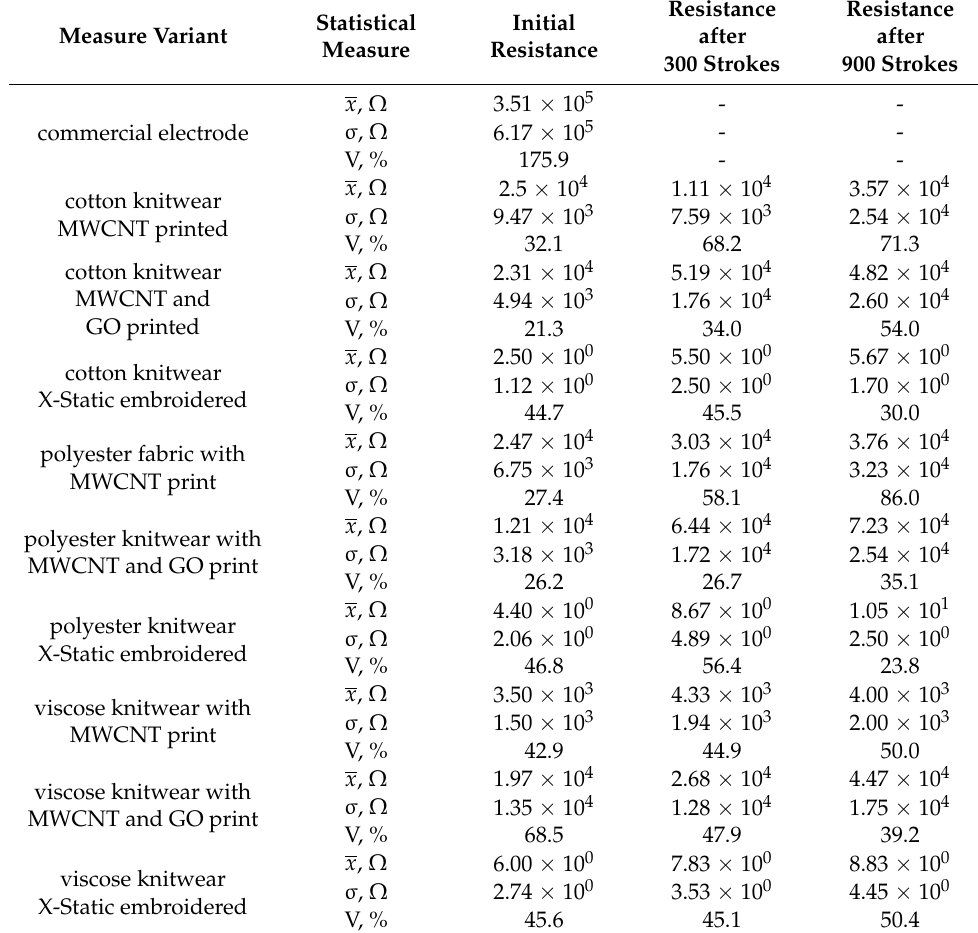
Table 5. Results of average values of surface resistances in test materials after